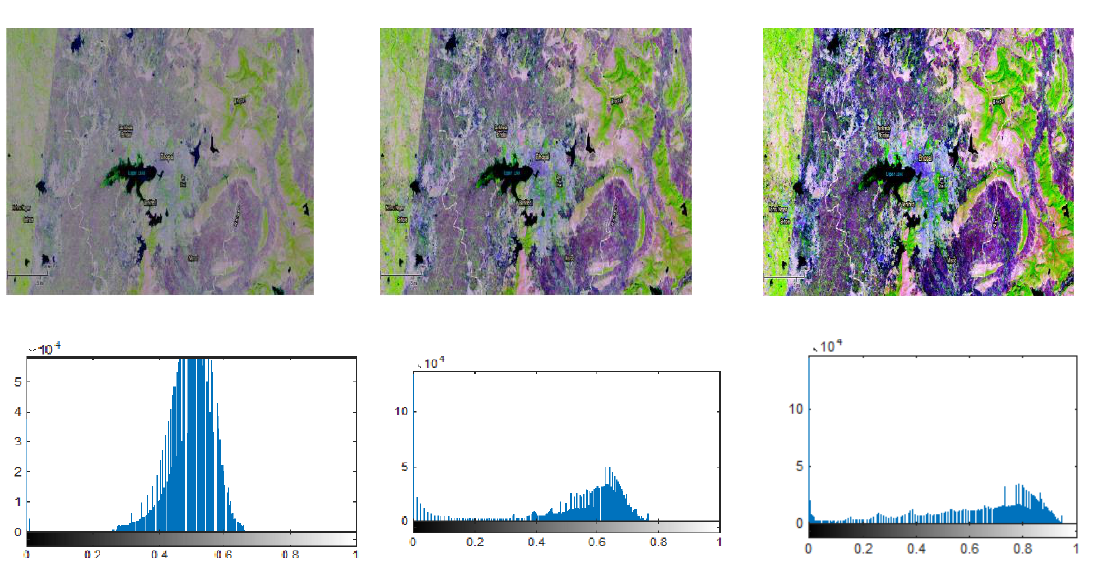
Figure 6. Histogram plots for image outputs.